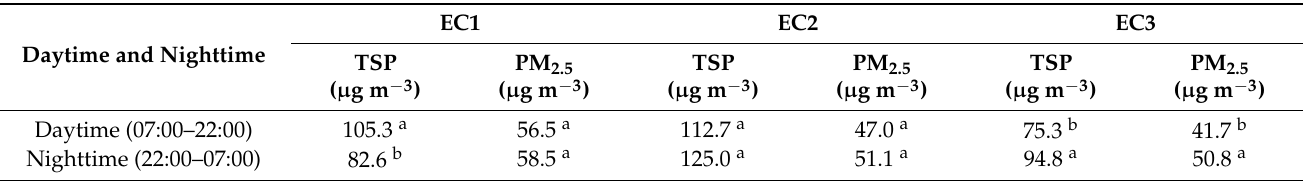
Table 3. Indoor TSP and PM 2.5 concentrations at daytime and nighttime in three